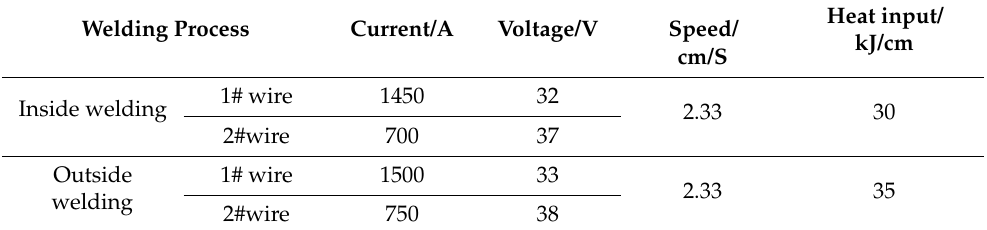
Table 2. Welding parameters.